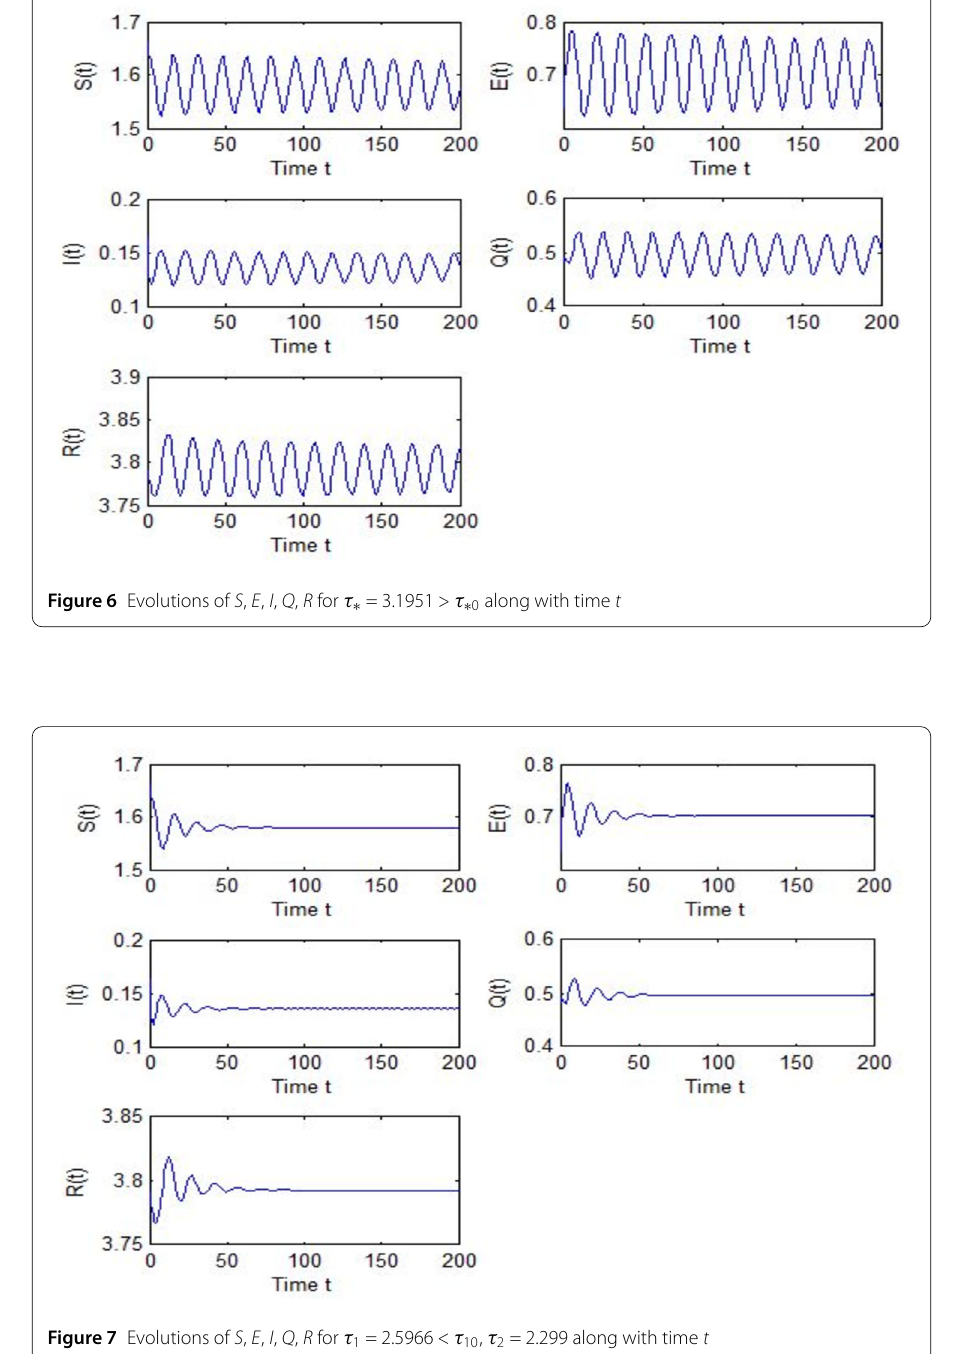
viduals have different quarantine rates, and this measure makes our new model practical. Time delays are applied during analyzing the new model, too. In the future, we will con- sider the nonlinear infection rate, which would lead to the increase of exposed individuals and infected